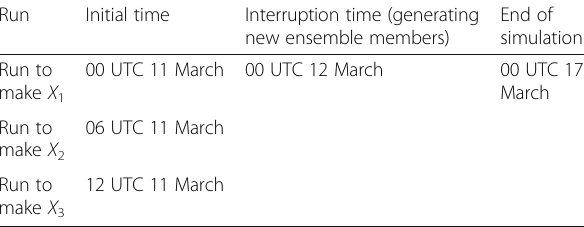
Table 4 Initial and interruption times of the WRF simulations.